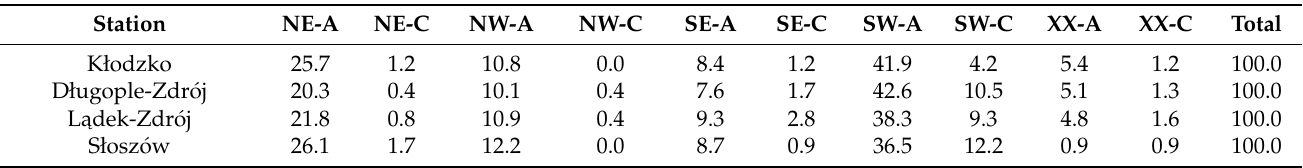
Table 7. Frequency of days (%) with UTCI > 32 ◦ C (June–August) under particular types of circulation in Kłodzko Land in 1971–2010, based on 12:00 UTC data.